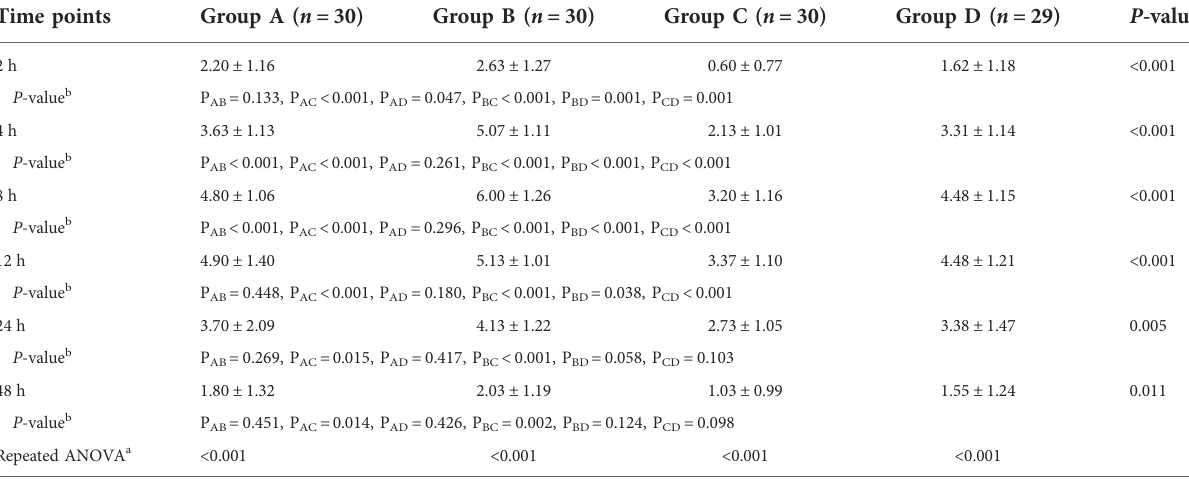
TABLE 2 Postoperative pain score at rest in study